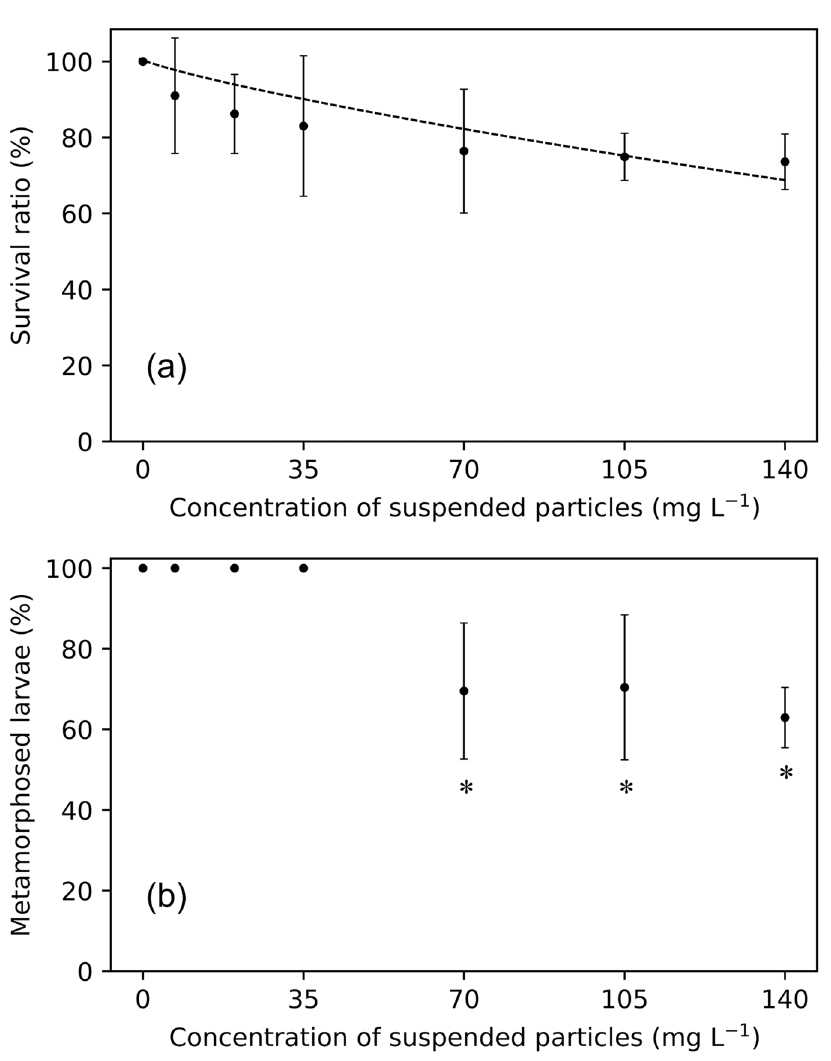
Figure 2. Survival and metamorphosis ratio of nauplius larvae; ( a ) relationship between relative survival ratio of nauplius larvae and suspended particle concentration ( p < 0.05), and ( b ) metamorphosis ratio (%) from nauplius to elaphocaris larvae; after 72 h of exposure in different suspended particle concentrations. An asterisk (*) indicates statistical differences at ( p < 0.05) when compared with the control condition.